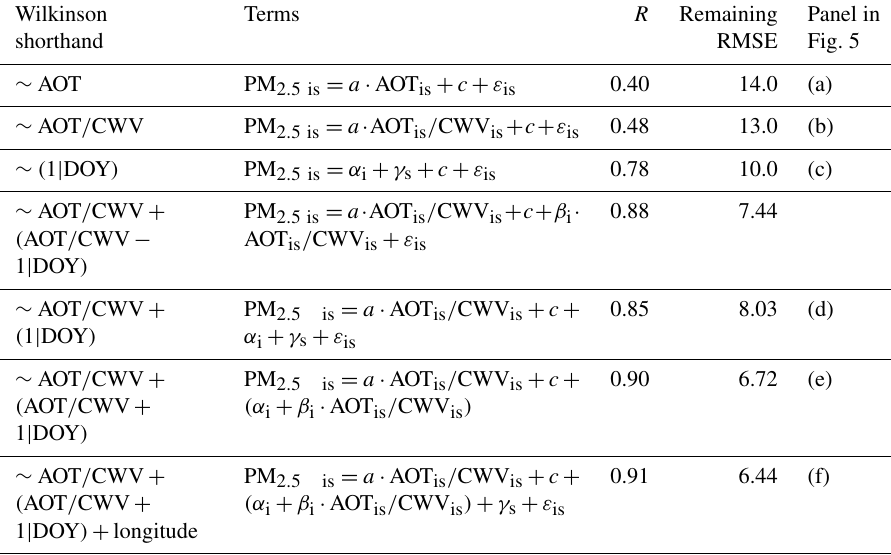
Table 1. Comparison of results using different terms in the mixed-effects model. Wilkinson Terms R Remaining Panel in shorthand RMSE Fig.